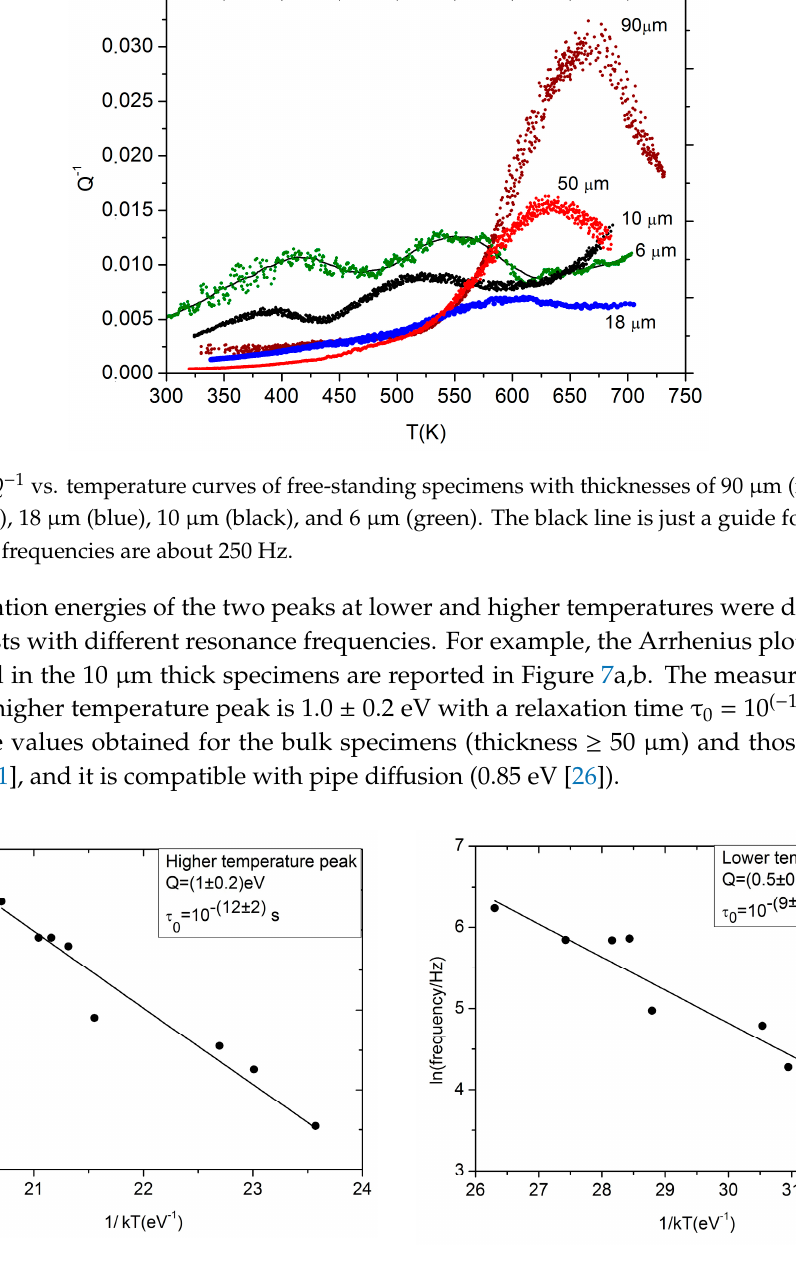
Figure 6. Q − 1 vs. temperature curves of free-standing specimens with thicknesses of 90 µm (magenta), 50 µm (red), 18 µm (blue), 10 µm (black), and 6 µm (green). The black line is just a guide for the eye. Resonance frequencies are about 250 Hz.